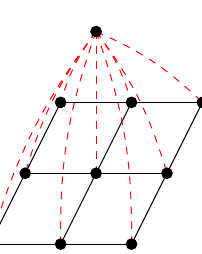
Figure 2. Diagram of a dummy node being added to the grid graph. Each node in the grid represents a pixel in the depth image. The dummy node is connected to each grid node by a single edge (dashed line).